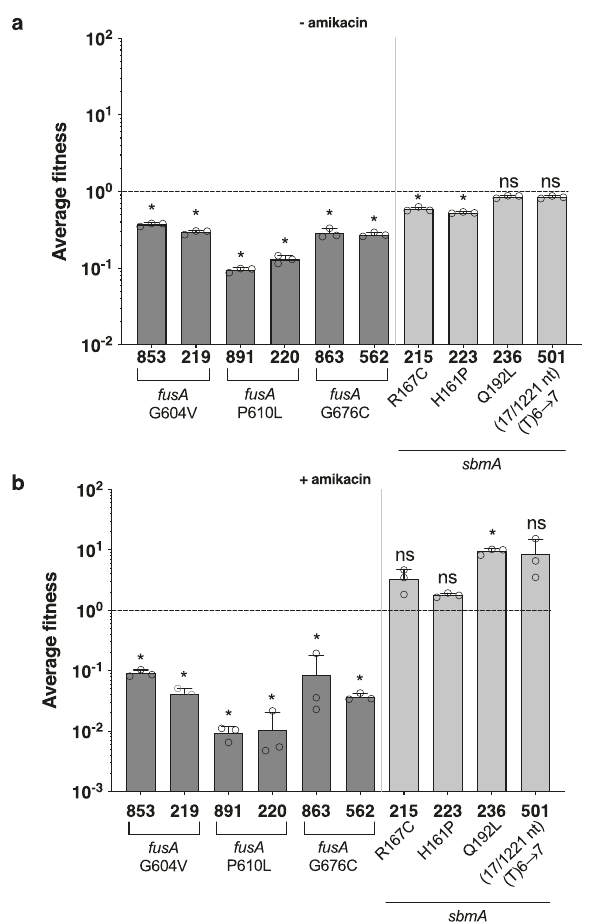
Fig. 6 Relative fi tness costs of evolved clones containing fusA and sbmA mutations. Each evolved clone tagged with mars was competed with wildtype tagged with GFP at a 1/1 ratio in the absence ( a ) and presence ( b ) of 5x AMK MIC. In order to match the evolution protocol, in ( a ) wt/ mutants LB overnight cultures were mixed, diluted to OD 0.02 and grown in LB for 24 h before fl ow cytometer analysis. In b wt/mutants LB overnight cultures were mixed, diluted to OD 2, treated for 24 h by 5x AMK MIC, washed, diluted 1/100 and regrow in LB for 24 h before fl ow cytometer analysis. The fi tness index of the comparison of wildtype tagged with mars to wildtype tagged with GFP is taken as 1 (dotted line). Detailed information on the different analysed clones can be found in supplementary Data 4. It should be noted that clones 853, 863 and 891 differ, respectively, from the ancestral strain by a single G604V, G676C and P610L fusA mutation, and clones 236 and 501 differ, respectively, from the ancestral strain by a single Q192L and (17/1221 nt) (T)6 → 7 sbmA mutation, and are otherwise isogenic. The data corresponded to n = 3 biological replicates for each clone and are represented as the mean ± SD. Statistics correspond to unpaired two-tailed t -test with Welch ’ s correction comparing each condition to wildtype/wildtype fi tness. ns, no signi fi cance; * p < 0.05; ** p < 0.01; *** p <